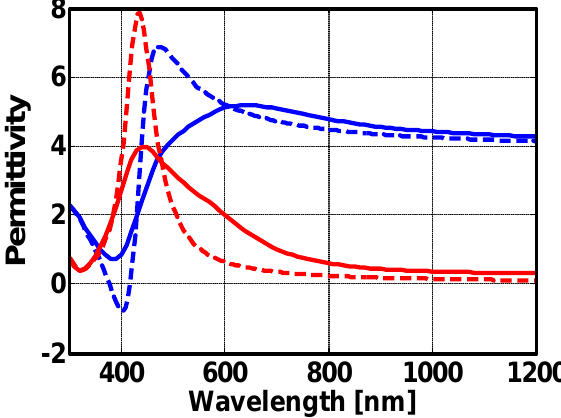
Figure 3. Effective properties of a plasmonic nanocomposite with a filling fraction of 20%. The effective properties are calculated by means of full wave finite-difference time-domain (FDTD) simulations (solid lines) and a Maxwell-Garnett effective medium theory (dashed line). The real part of the effective permittivity is shown in blue whereas the imaginary part is shown in